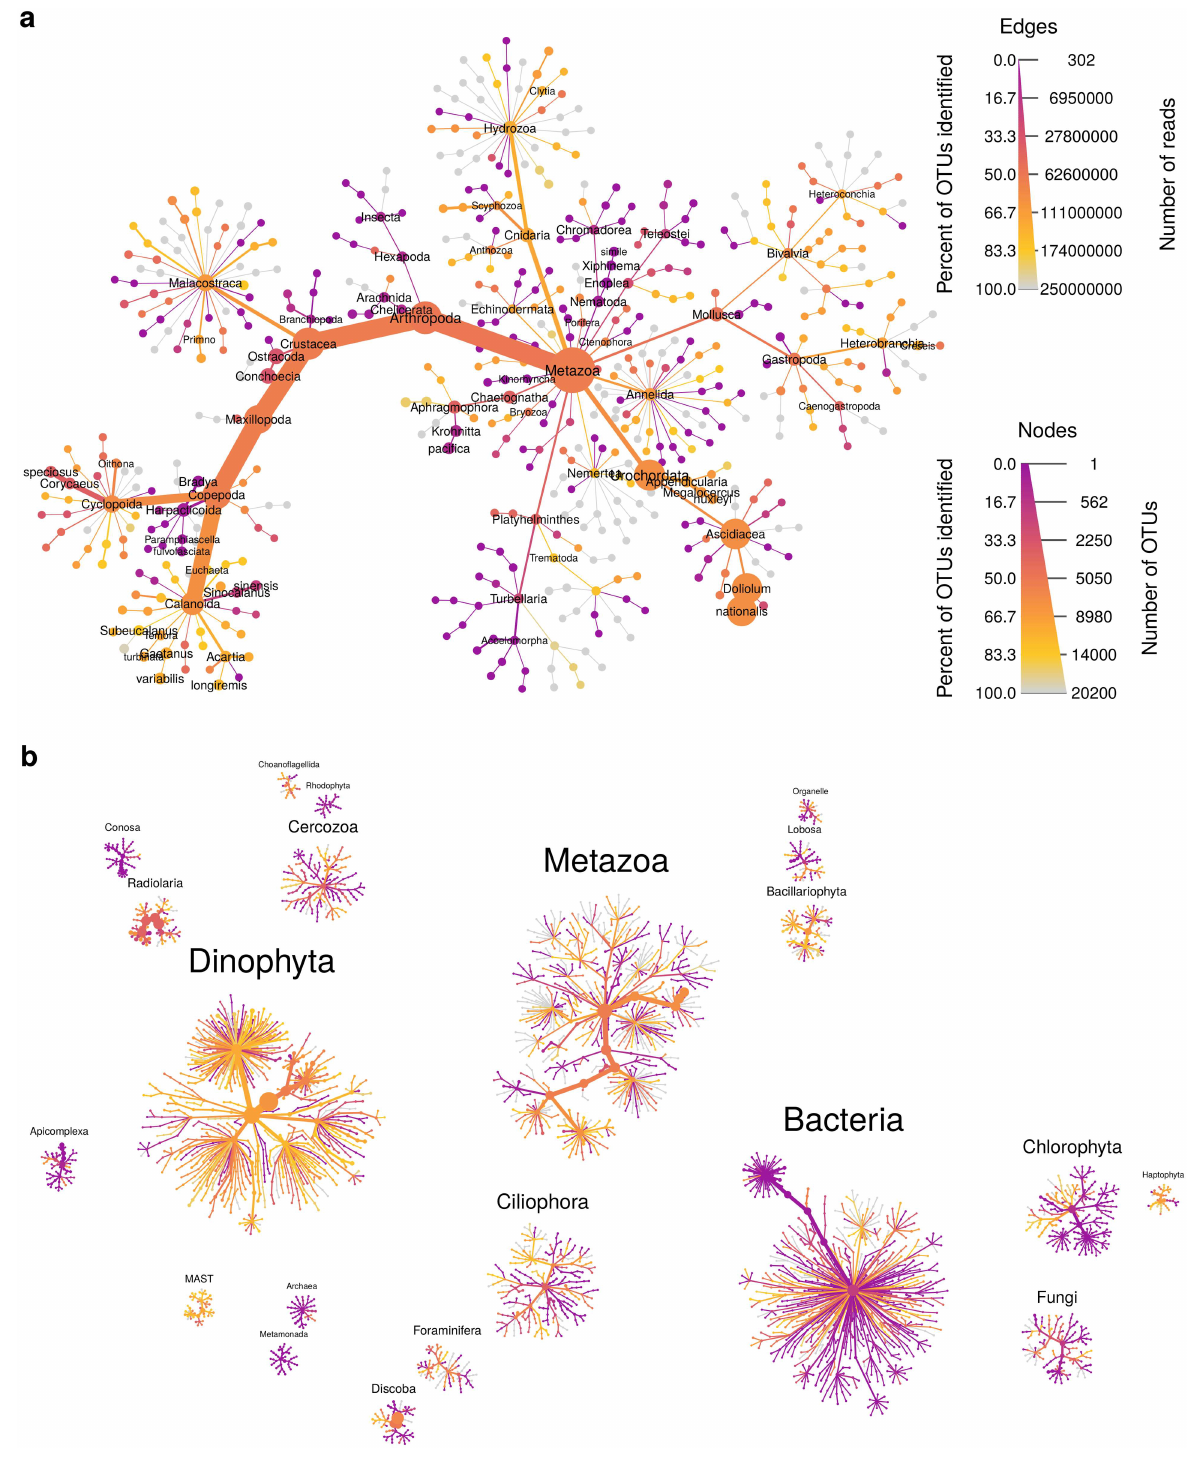
Fig 3. Heat trees display up to four metricsin a taxonomic context and can plot multiple trees per graph. Most graph components, such as the size and color of text, nodes, and edges, can be automatically mapped to arbitrary numbers, allowingfor a quantitative representation of multiple statistics simultaneously. This graph depicts the uncertaintyof OTU classificationsfrom the TARA globaloceans survey [2]. Each node represents a taxon used to classify OTUs and the edges determine where it fits in the overall taxonomic hierarchy. Node diameteris proportional to the numberof OTUs classifiedas that taxon and edge width is proportional to the